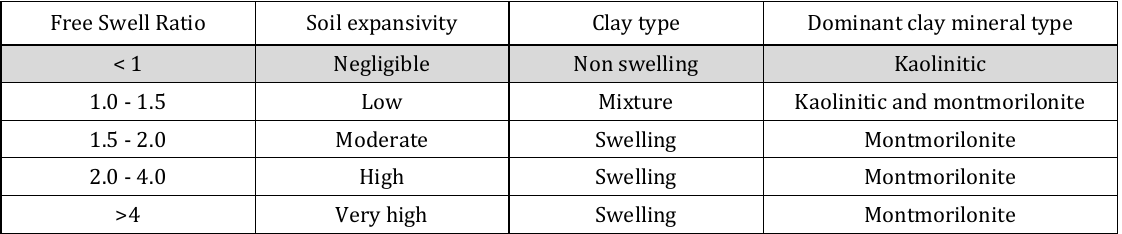
Table 1. Free Swell Ratio (FSR) table (the grey shading is the FSR value in all soil sample) Free Swell